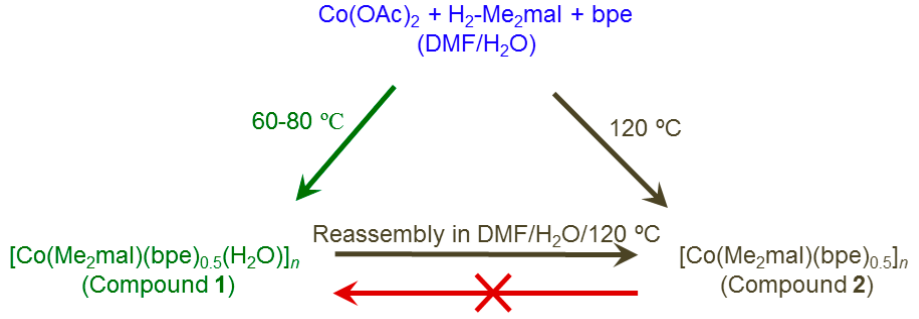
Scheme 1. The Schematic representation of the temperature-controlled assembly/reassembly of compounds 1 and 2